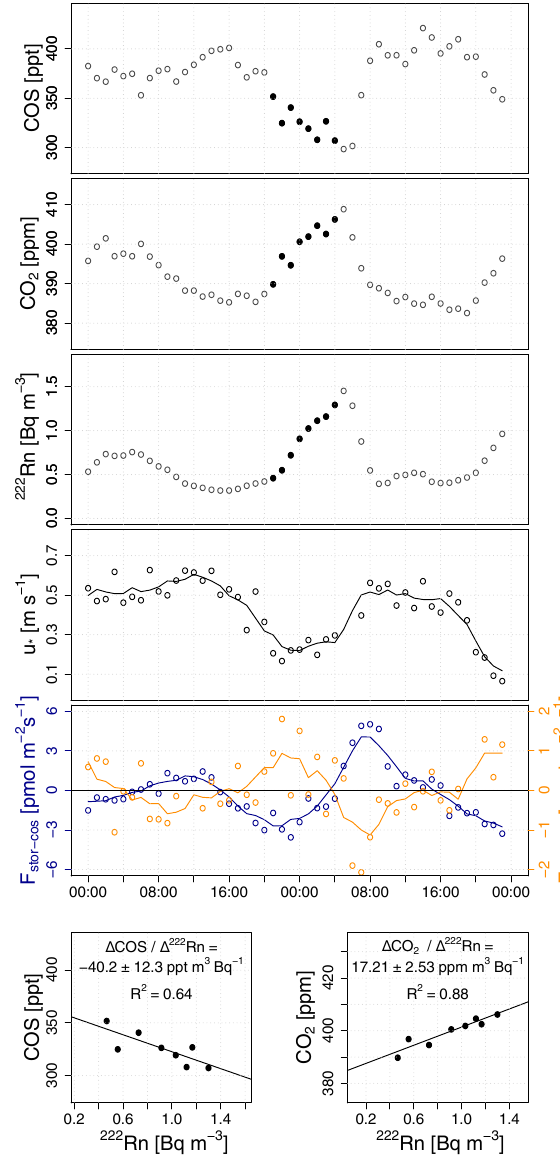
Figure 1. COS, CO 2 and 222 Rn concentrations, u ∗ and the stor- age flux of COS and CO 2 ( F stor-COS and F stor-CO 13 July 2015, where the data with sun elevation below 0 ◦ are used to derive nighttime fluxes of COS and CO 2 (black, filled). The bottom figures show the linear regression between 222 Rn and COS (left) and CO 2 concentrations (right) on which F COS-Rn and NEE Rn are